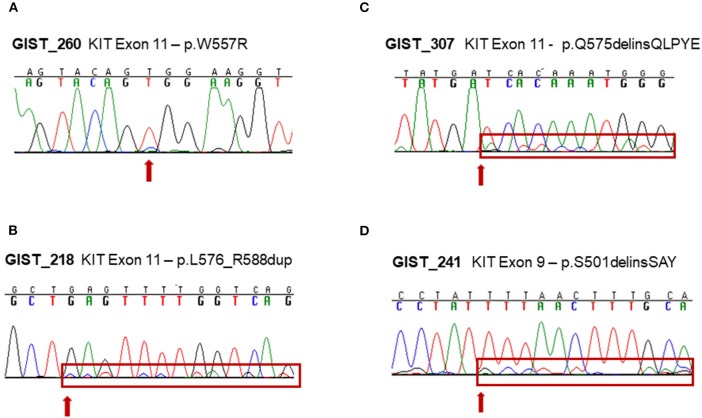
Experimental validation of low-allele-fraction mutations in GIST samples by Sanger sequencing. (A) KIT exon 11 c.T1657C mutation in GIST_260. (B) KIT exon 11 c.1726insC;1726_1764dup mutation in GIST_218. (C) KIT exon 11 c.1723_1724insAACTTCCTTATG in-frame insertion in GIST_307. (D) KIT exon 9 c.1502_1503insTGCCTA in-frame insertion in GIST_241.